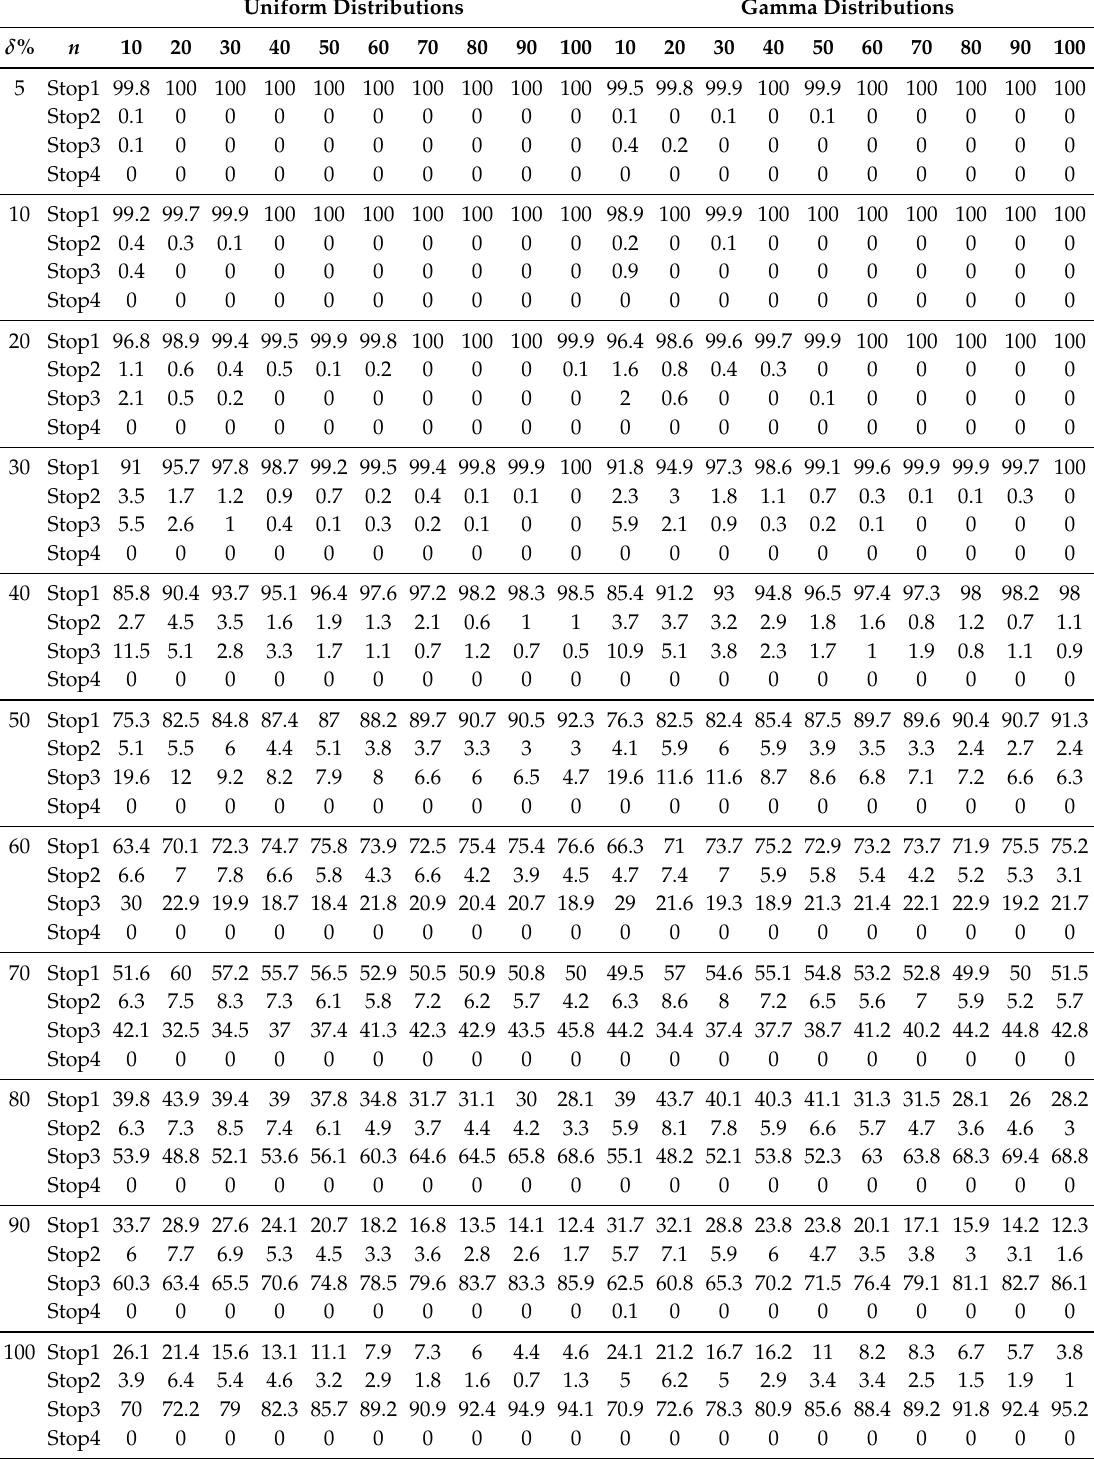
Table A4. Computational results for randomly generated instances with the ratio 0%:0%:40%:60% of the numbers of jobs in the subsets J 1 , J 2 , J 1,2 and J 2,1 of the job set J